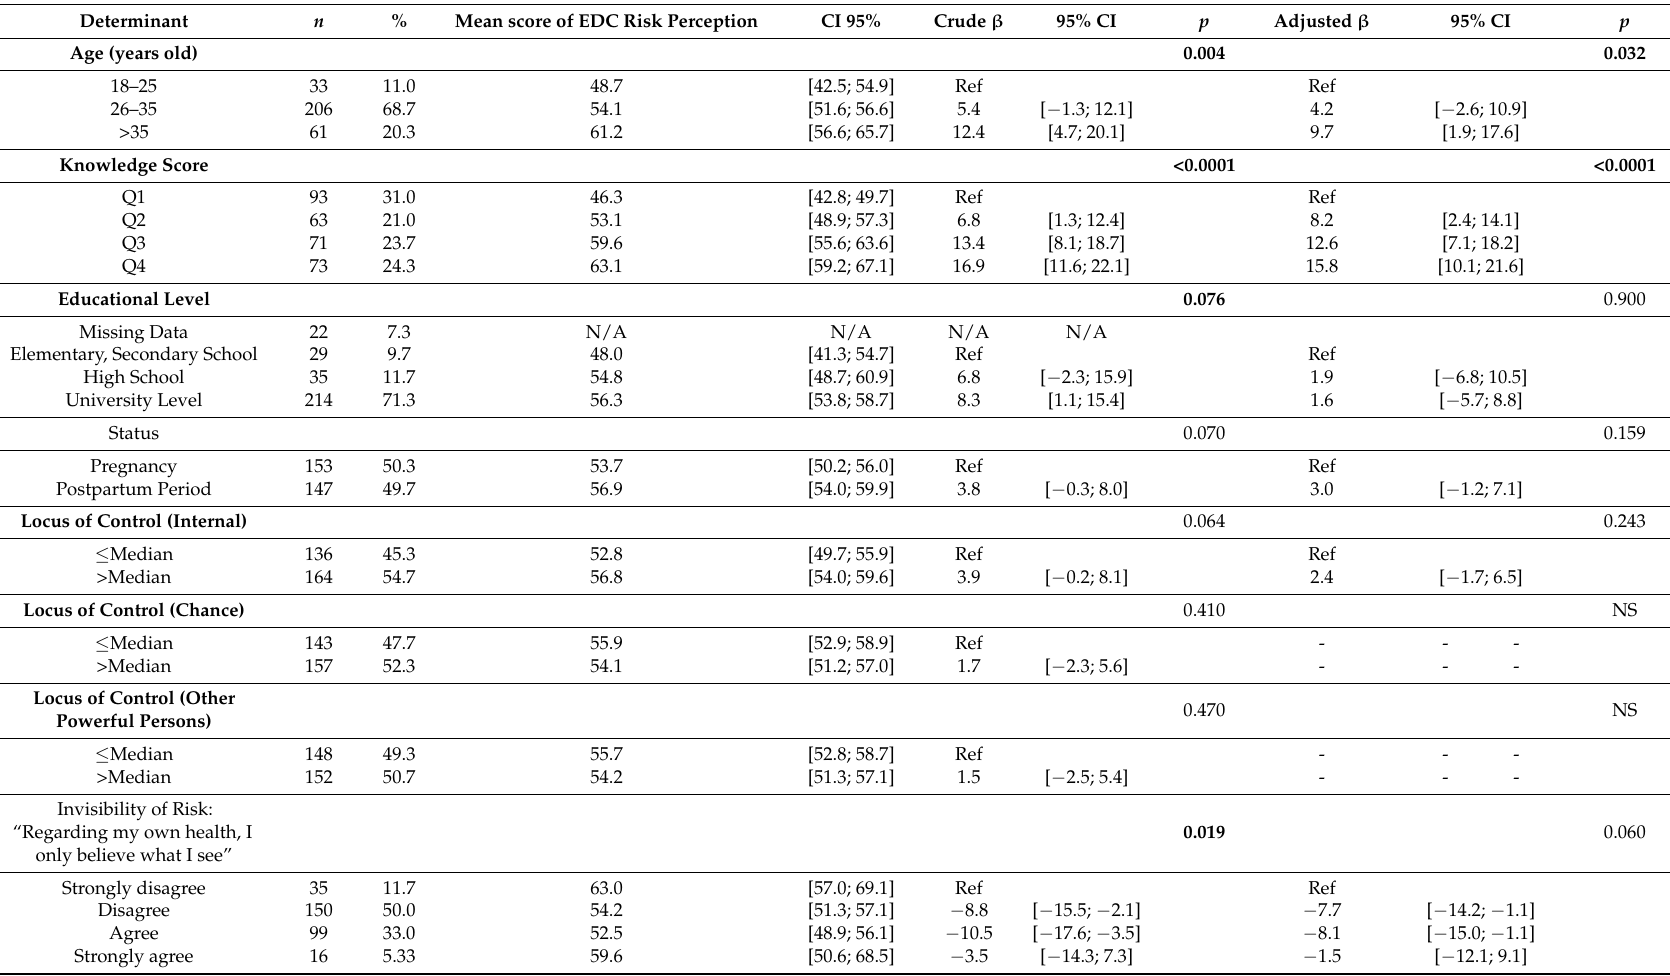
Table 4. Determinants of endocrine disruptor chemicals (EDC) risk